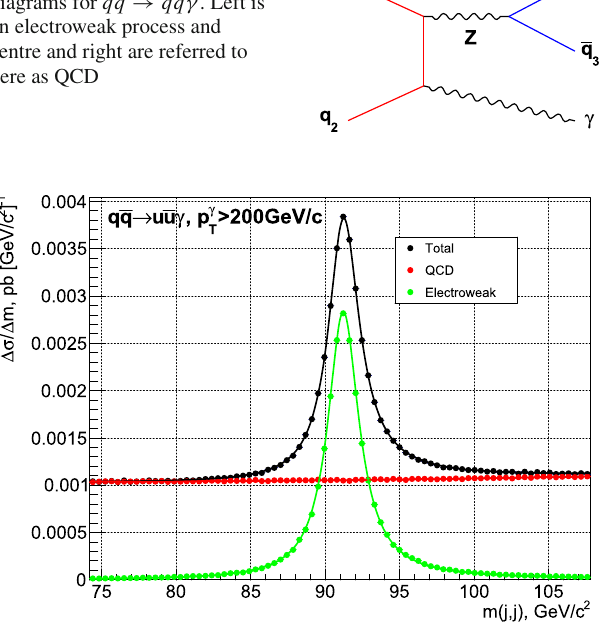
Fig. 8 Example Feynman diagrams for qq → qq γ . Left is an electroweak process and centre and right are referred to here as QCD